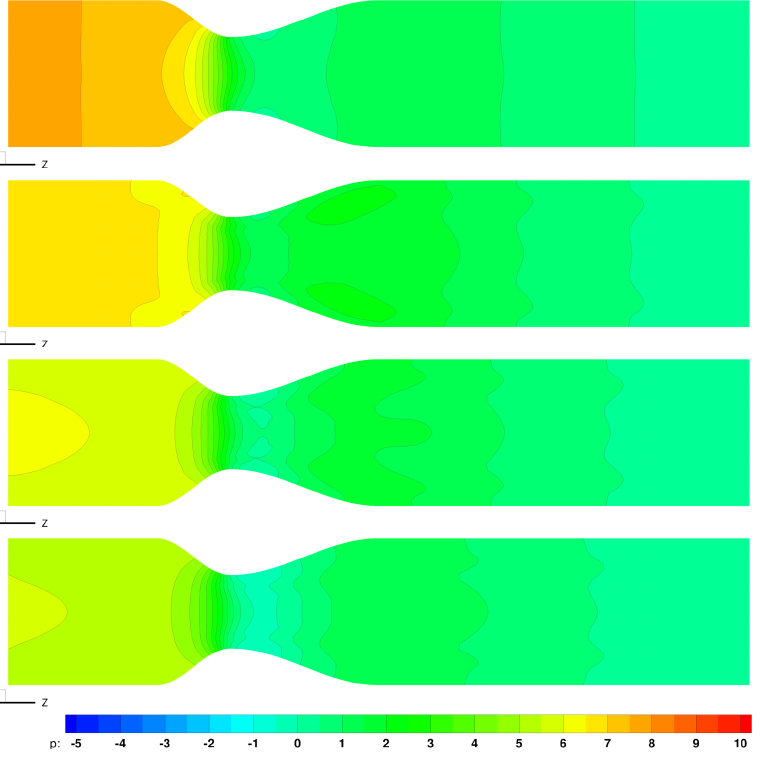
Figure 21. Pressure at flow rate Q = 0.5 cm 3 /s — GOB (top figure) and Johnson–Segalman models for a = − 0.9, a = − 0.8, a = − 0.7 (from the